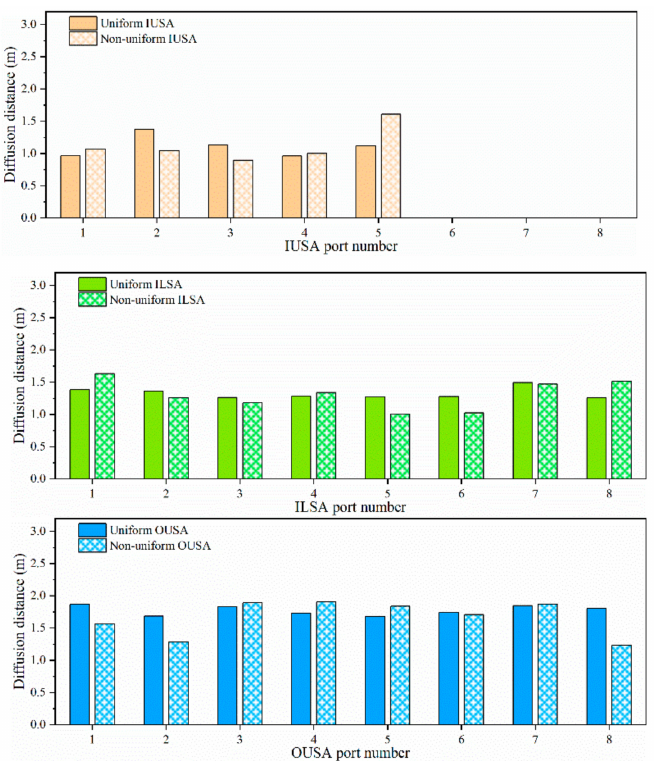
Figure 9. Lateral diffusion distance under (non-)uniform SA distributions at 100% BMCR load. Table 5. Standard deviations of lateral diffusion distance of various SA at 100% BMCR load (unit: m). Working